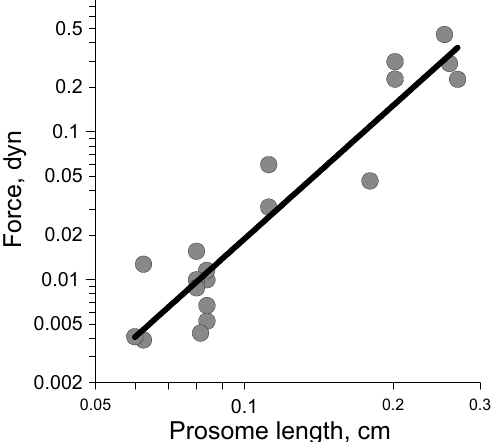
Figure 14. Drag force versus prosome length calculated for free cruise-swimming copepods, ( R d = 11.5 L 2.82 (R 2 = 0.86). All points are average values.